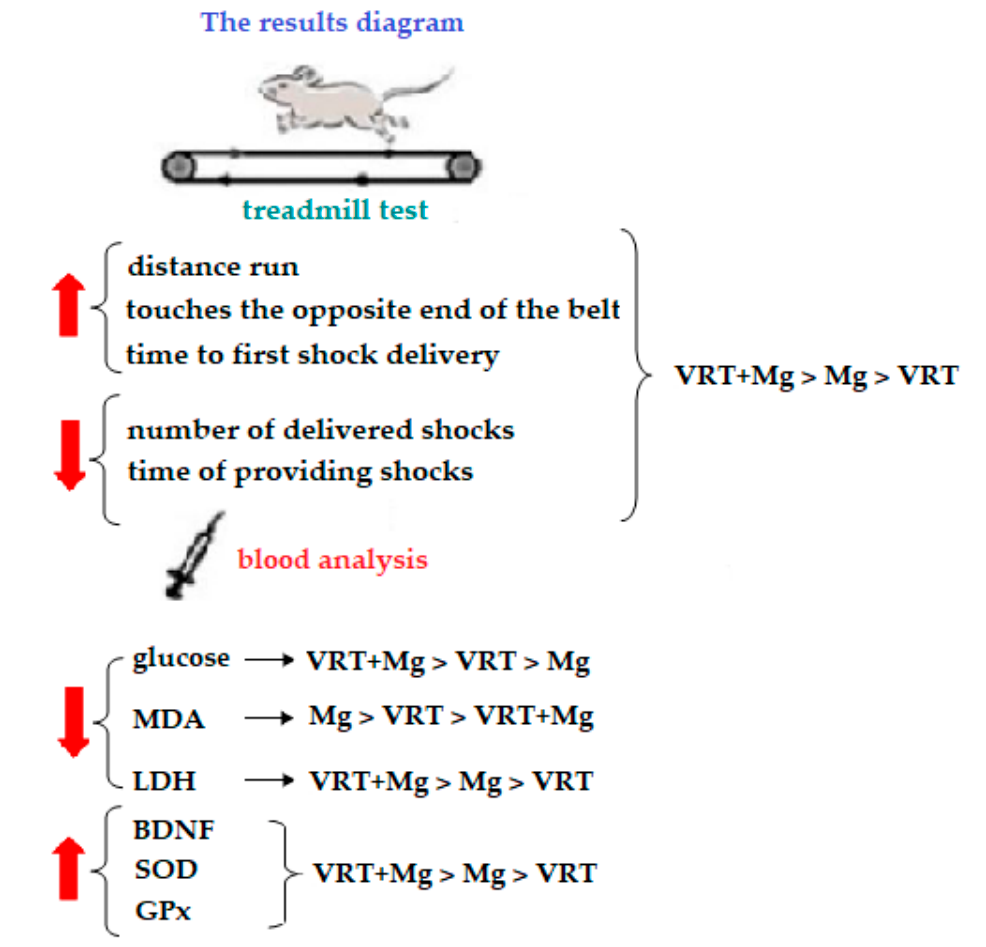
Figure 4. The main findings of the study.